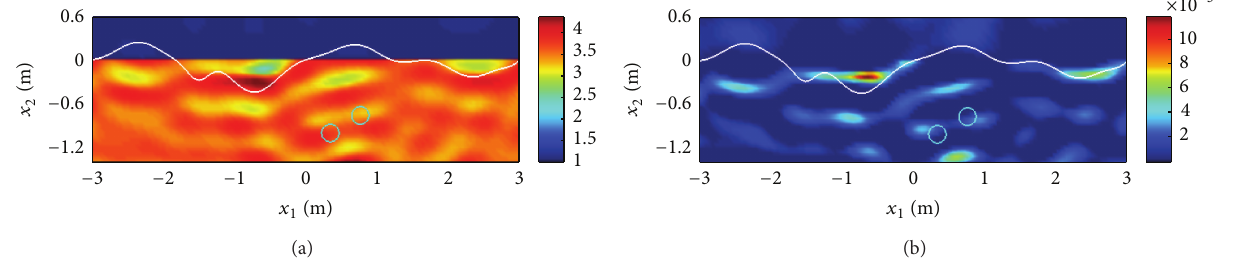
Figure 4: (a) Reconstructed permittivity and (b) conductivity profiles for the direct application of the CSI on a planarly layered background at 150 MHz.